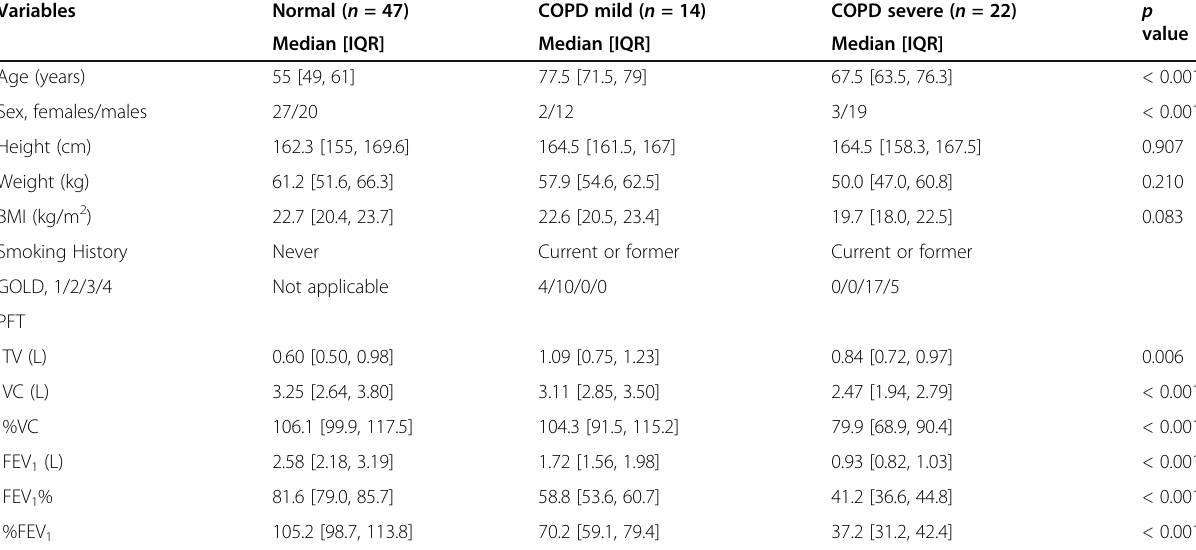
Table 1 Demographic data and PFTs among normal, COPD mild, and COPD severe groups